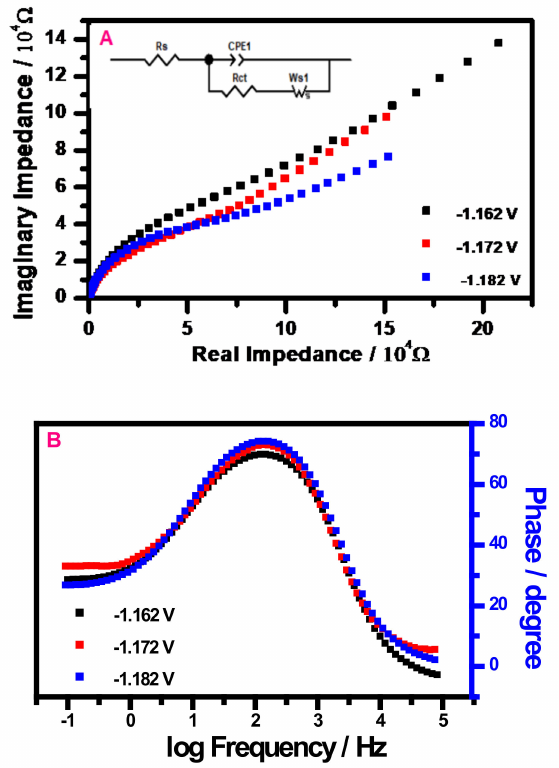
Figure 6. Nyquist plot ( A ) and Bode plot ( B ) of G1PPT-co-P3HT in 0.1 M Bu 4 NPF 6 in acetonitrile at 1.182 V [1]. Table 2. Electrochemical parameters of G1PPT-co-P3HT obtained from EIS measurements [1]. E (cid:48)